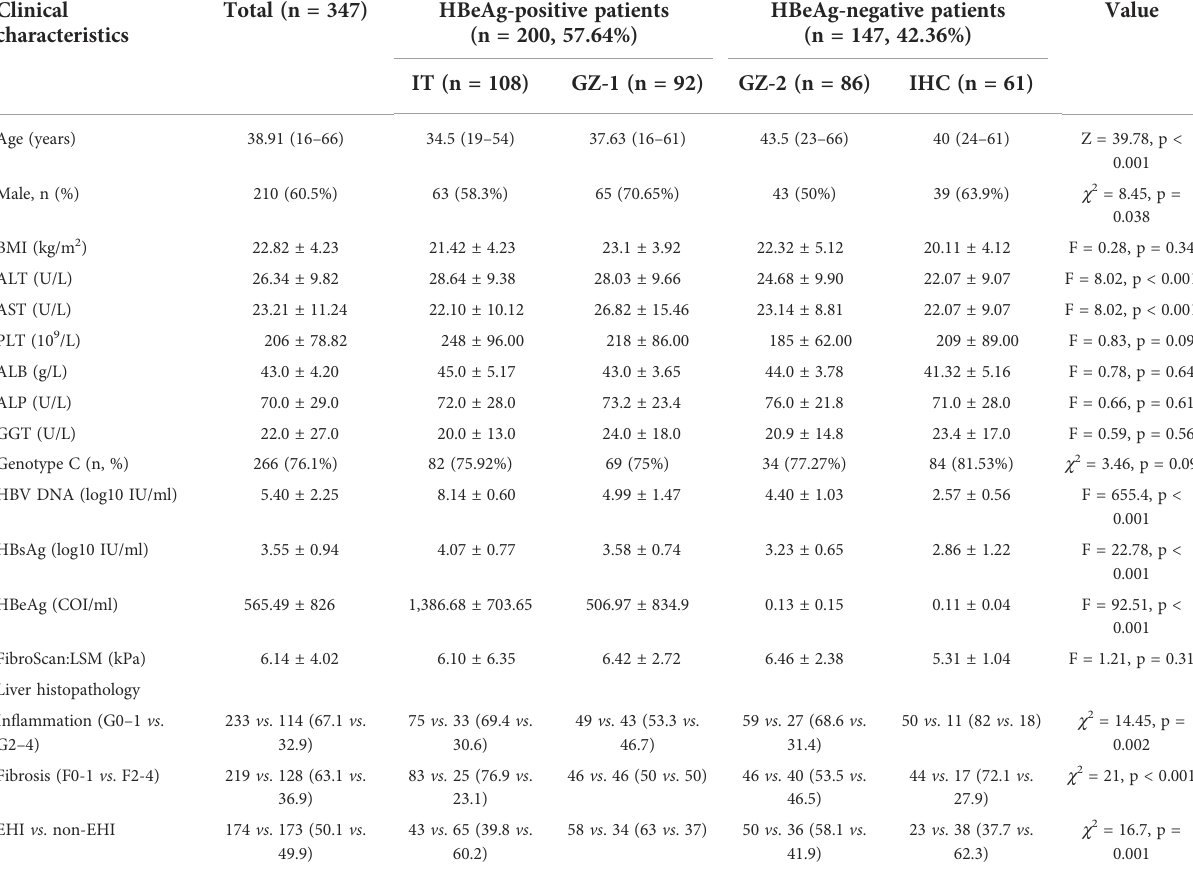
TABLE 1 Baseline characteristics of enrolled patients. Clinical